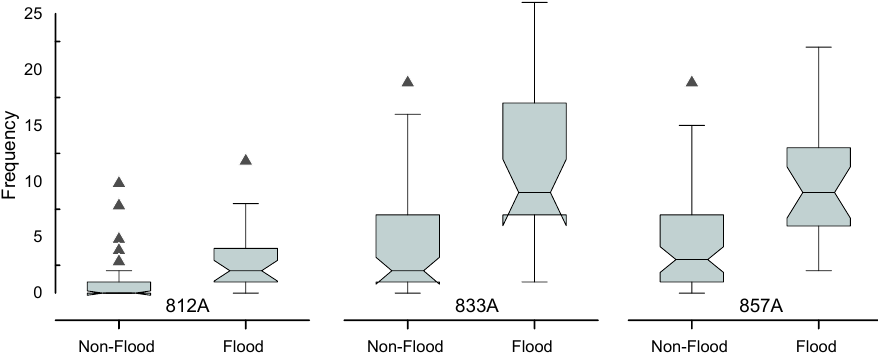
Figure 4. Boxplot with word distribution for flood days and non-flood days at the three points of the study area (812A, 833A, and 857A rain gauges). The notched box represents a 95% confidence interval, and the triangles are values out of the ± 1.5 × interquartile range. When we refer to “frequency”, we are specifically referring to the number of times a tweet keyword appears in the analyzed tweets, expressed as an absolute count. On the x -axis, the distribution of days with and without flooding is represented by the flooding and non-flooding days,